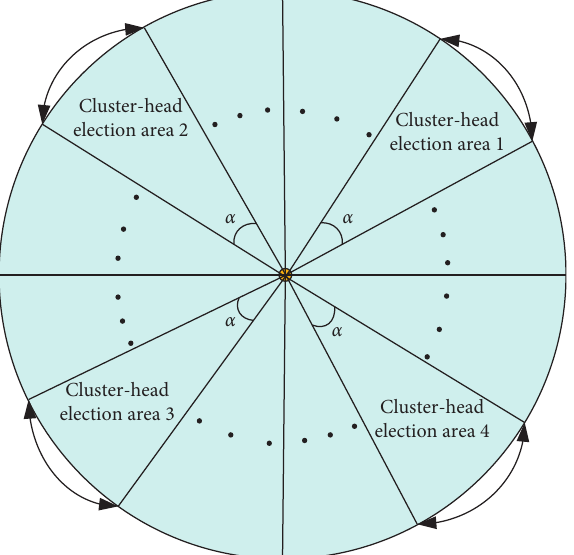
Figure 3: Heterogeneous multilayered network